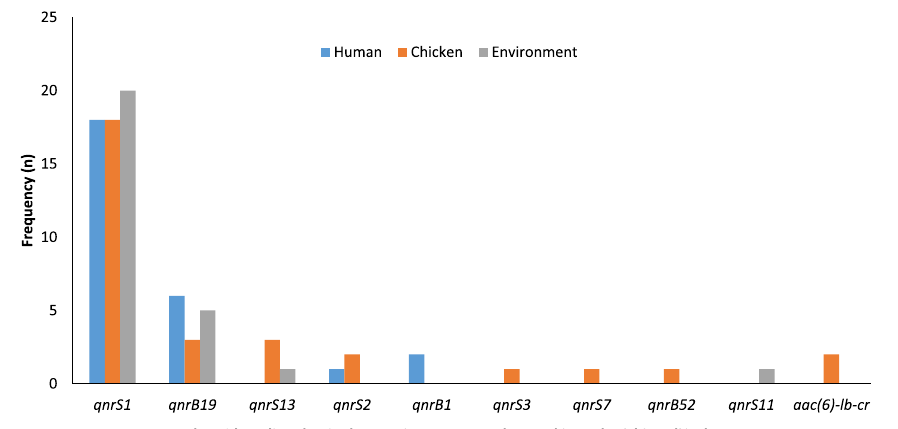
Fig. 1 Distribution of PMQR genes in 70 Escherichia coli isolates originating from humans, chickens, and the poultry farm/market